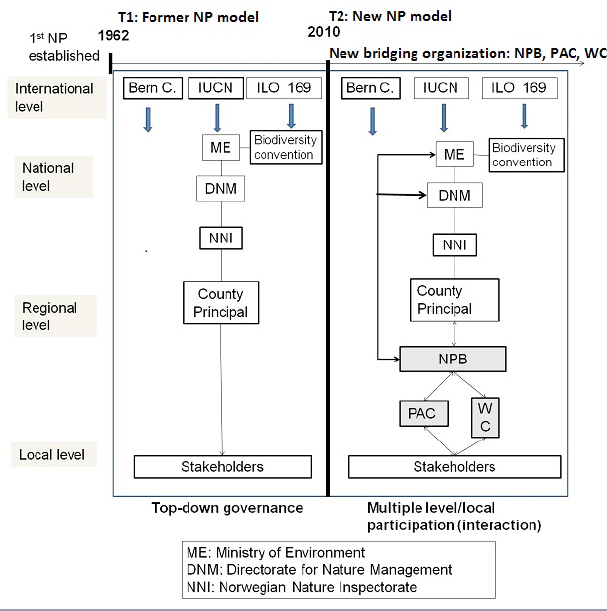
Fig. 2 . Cross-scale linkages before and after the new national park (NP) model. (NPB: National Park Board; PAC: Professional Advisory Committee; WC: Working